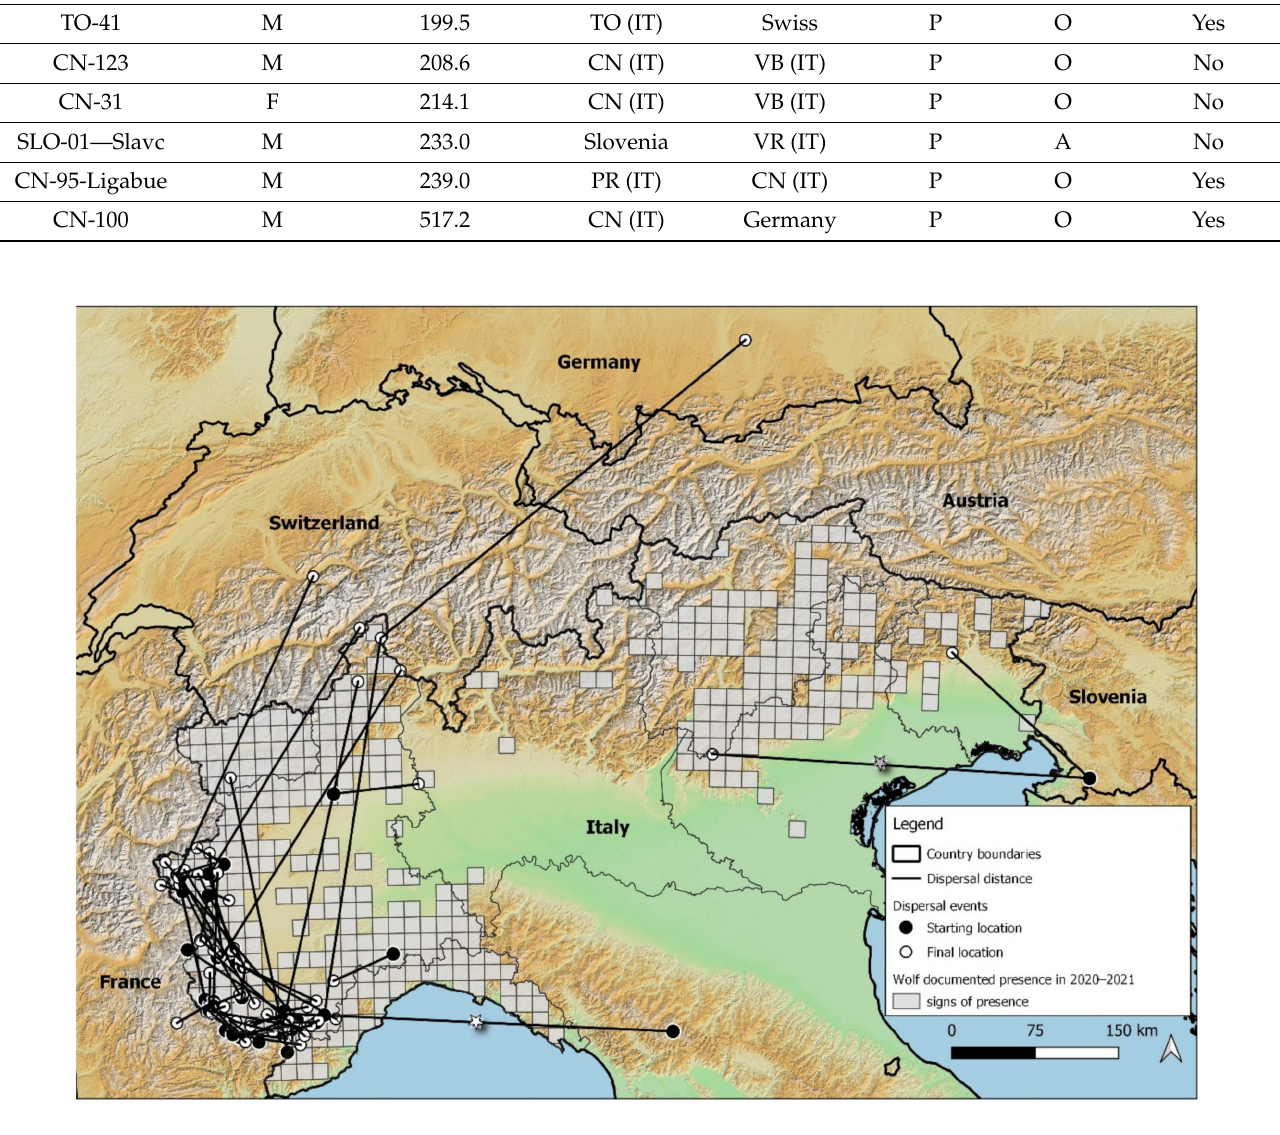
Figure 1. Distribution of dispersal events over the Alps documented by non-invasive genetic analysis over 20 years (from 2001 to 2021). The stars indicate dispersal events also documented by means of GPS collars in two published studies, cited for comparison to the genetic tools used in this study; the white star by [45], the grey star by